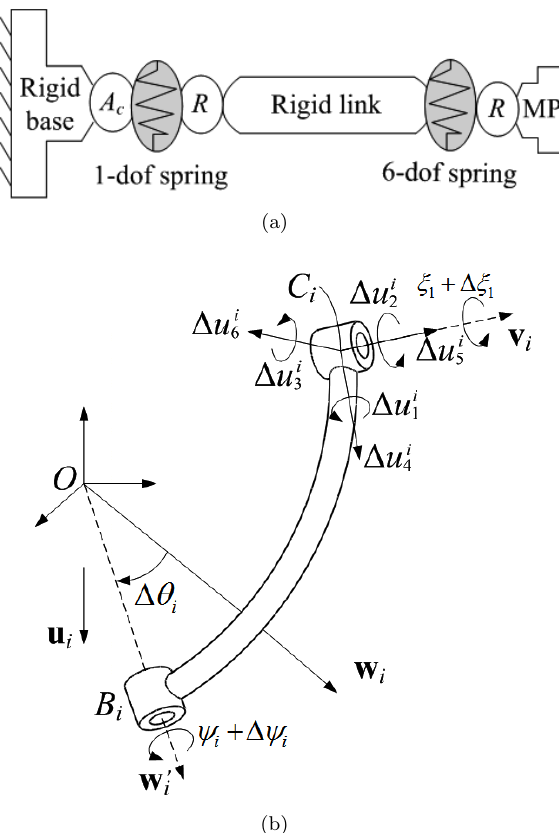
Figure 3: Flexible model of a single leg: (a) virtual spring model, where A c stands for the actua- tor, R for revolute joints and MP for the mo- bile platform, (b) link deflections and joint variations in the i th